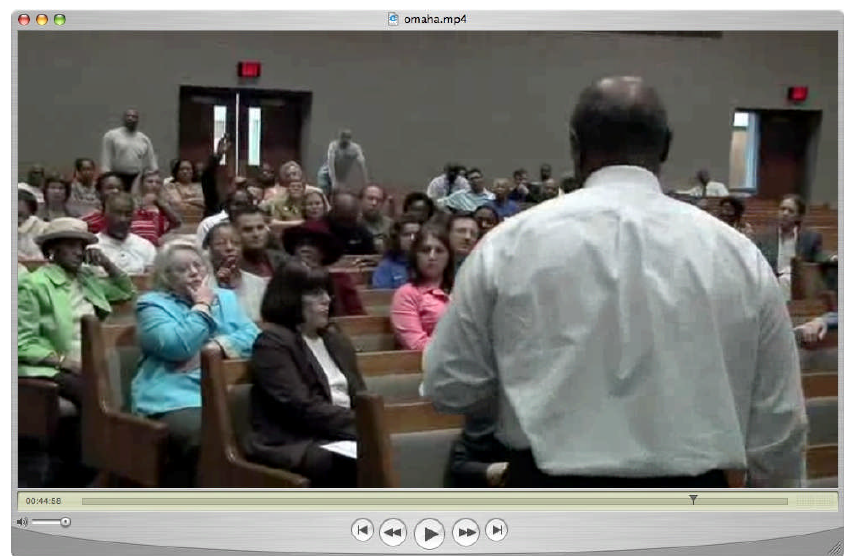
Figure 16: LADY: Line